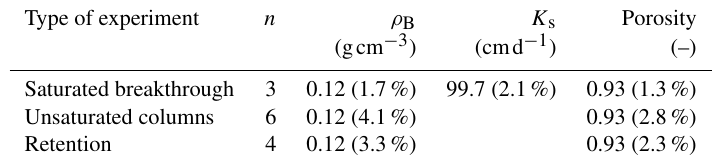
Table 1. Soil physical and hydraulic properties of prepared peat cores from different experiments. Values are averages; percentages in brackets are the coefficients of variation. Porosity was calculated using particle density for the constructed fen peat from Ketcheson (2015).